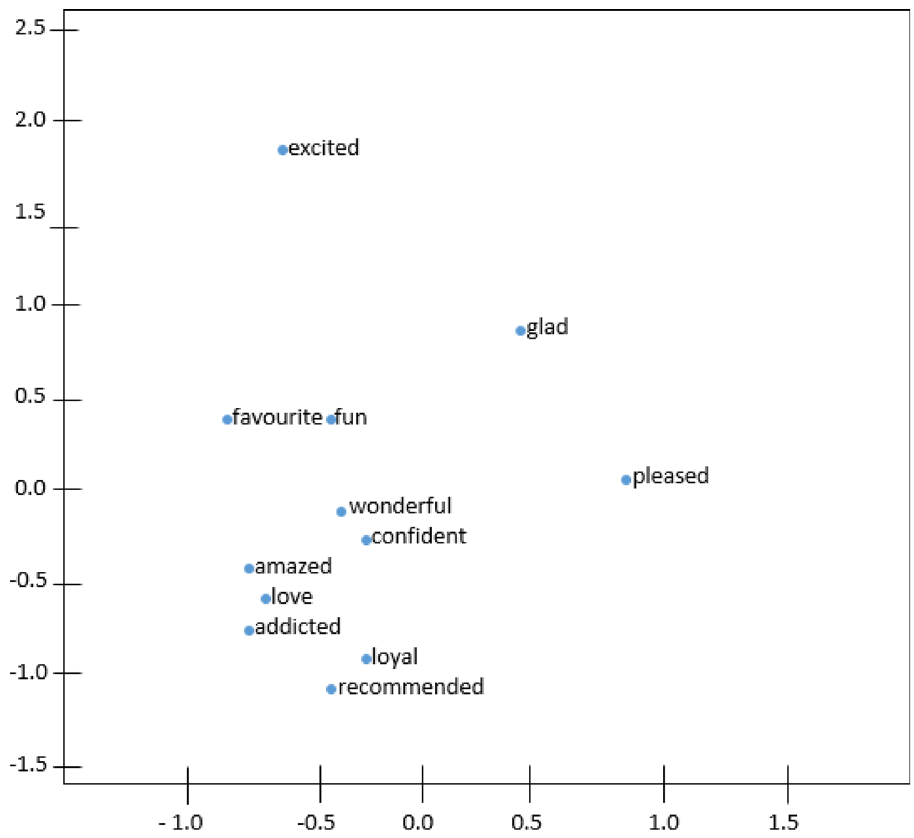
Figure 5. t-SNE plots of ‘ happy ’ on the ShopeeRD.